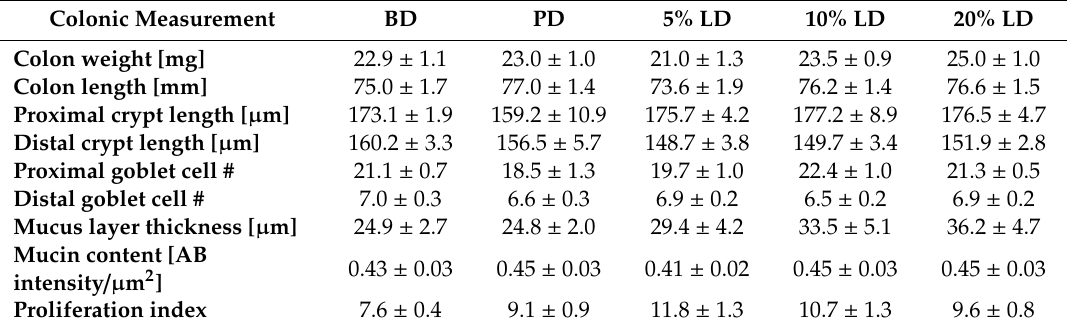
Figure 3. The e ff ects of lentil supplementation on fecal microbial activity. ( a ) Fecal pH; ( b ) fecal branched-chain fatty acids (BCFAs) ( µ mol / g DW), and ( c ) fecal short-chain fatty acids (SCFAs) ( µ mol / g DW) of C57bl / 6 male mice fed experimental diets for 3 weeks. Values are mean ± SEM; Columns without a common letter di ff er significantly ( n = 9 / group; p < 0.05). BD = basal diet; PD = pectin diet; LD = lentil diet. Table 3. Colon histomorphometrics following the 3-week consumption of experimental